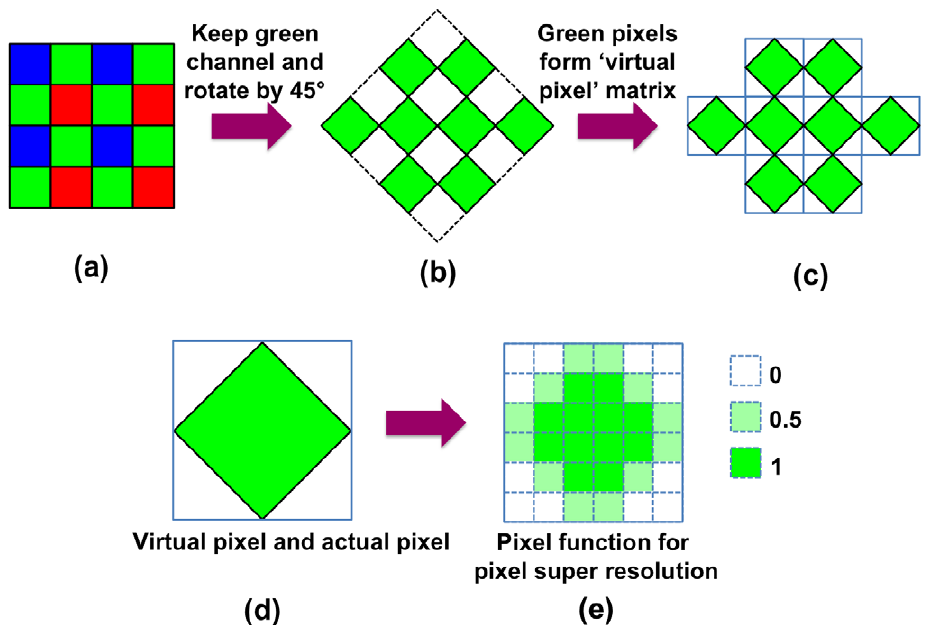
Figure 2. Overview of the method for obtaining grayscale holograms using color imaging sensors. Illustrates the method used to obtain a grayscale hologram using a colour sensor-array. (a) First, the green pixels are selected from the raw output image of the sensor. (b) The resultant data array is rotated 45 u to obtain virtual pixels. (c) Virtual pixel-array is obtained from the rotated array of green pixels in (b). (d) Shows a single ‘‘virtual pixel’’, which is a unit element of the pixel-array shown in (c). (e) The weighted pixel function to be used in pixel super-resolution is obtained, representing the 2D spatial map of light collection within a virtual pixel. on-chip microscopy system based on a color CMOS imager, achieving a numerical aperture (NA) of , 0.8.